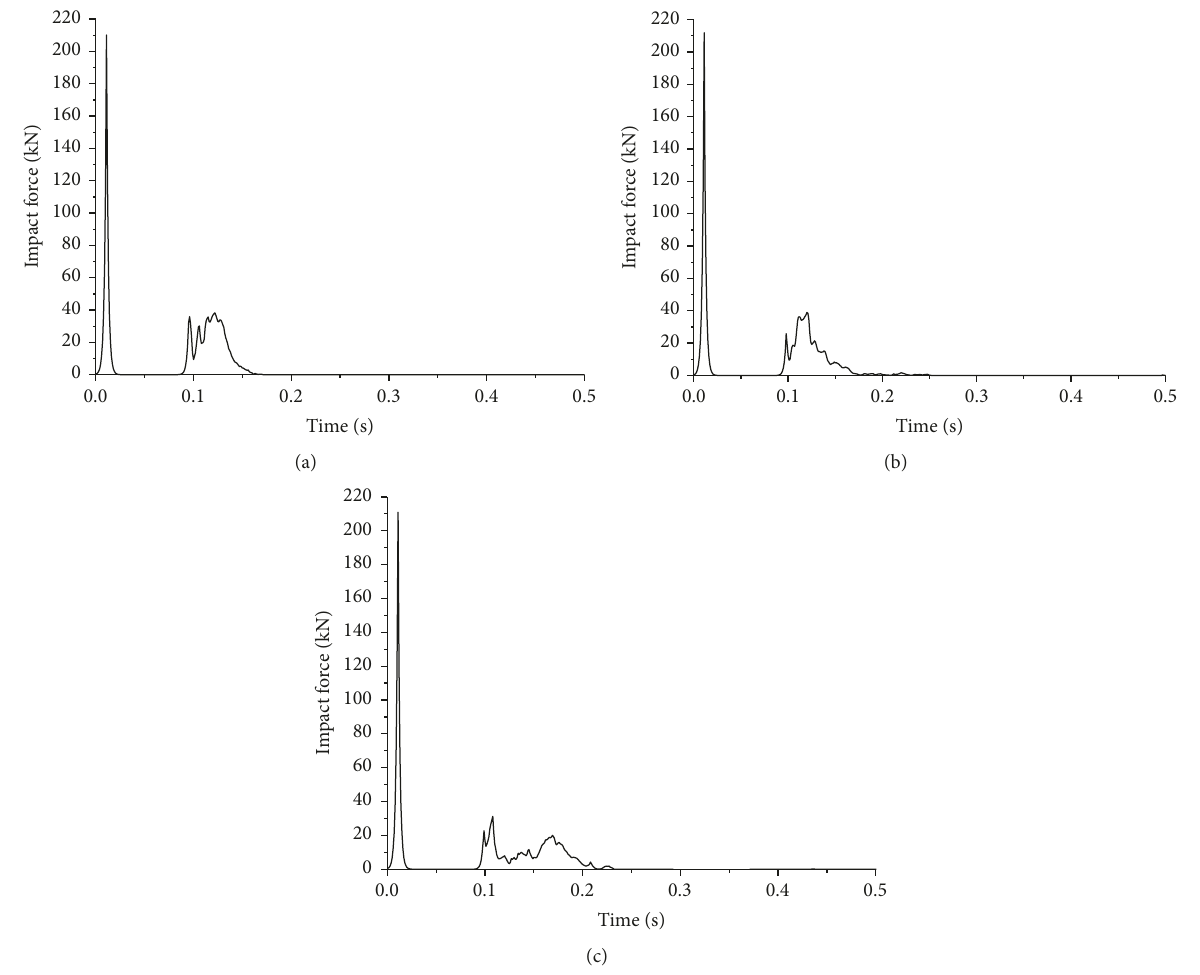
Figure 9: Impact time history curves: (a) model 1, (b) model 2, and (c) model 3.